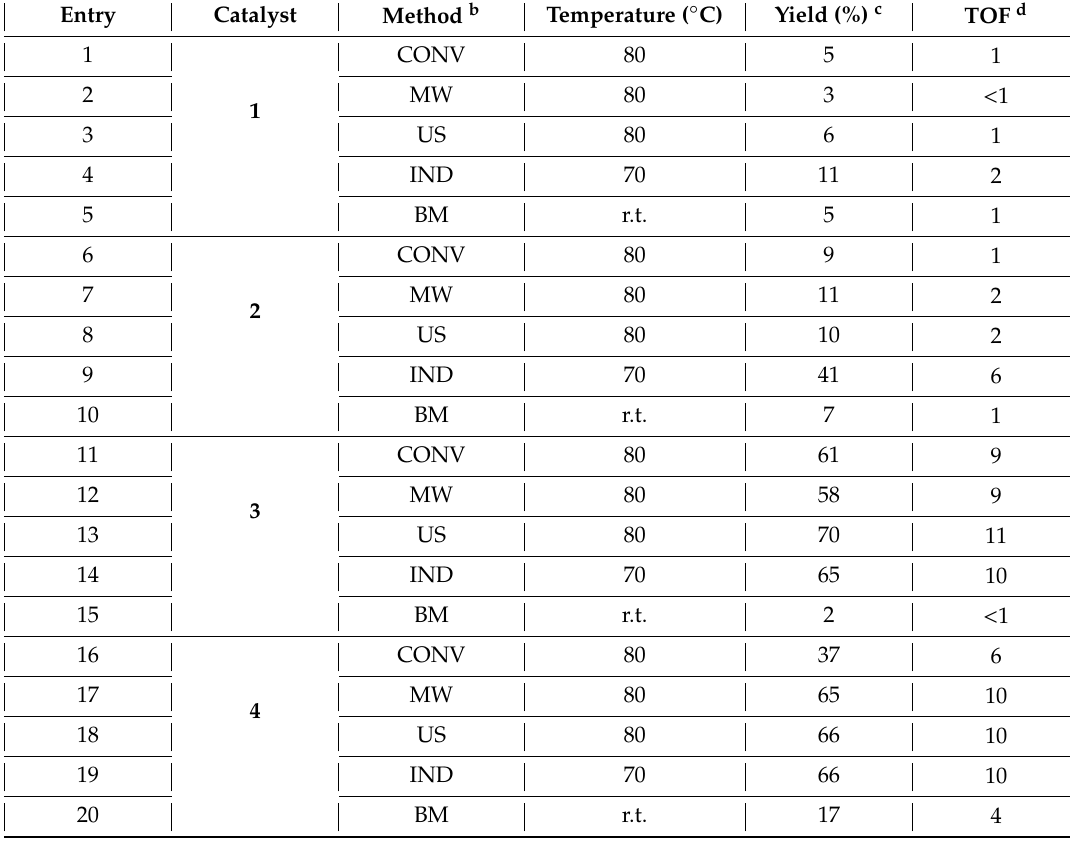
Table 4. E ff ect of the di ff erent energy inputs for the oxidation of 1-phenylethanol to acetophenone by 1 – 4 .